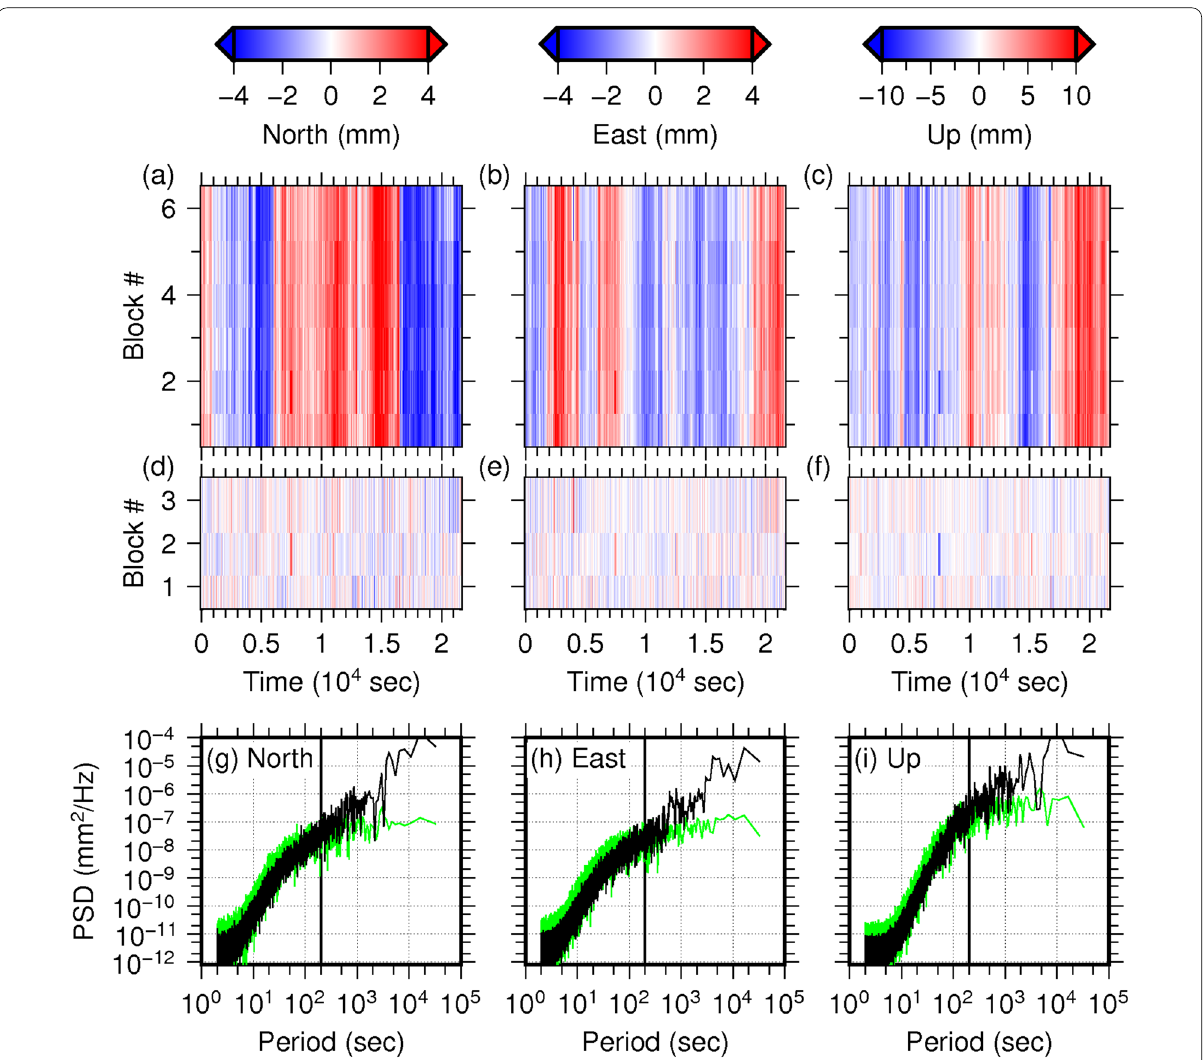
Fig. 10 Sidereal filtering results applied to the 1-Hz time series of the GODE-GODN baseline. a – c North ( a ), east ( b ), and up ( c ) coordinate fluctuations. Neither low-pass filtering (LPF) nor sidereal filtering (SRF) is applied. d – f North ( d ), east ( e ), and up ( f ) coordinate fluctuations (color) after sidereal filtering without low-pass filtering to the sidereal filter. g – i Average of power spectral density (PSD) of each block of 1-Hz kinematic coordinates. North ( g ), east ( h ), and up ( i ) PSD before (black) and after sidereal filtering without low-pass filtering to the sidereal filter (green). Vertical thick line indicates a period of 200